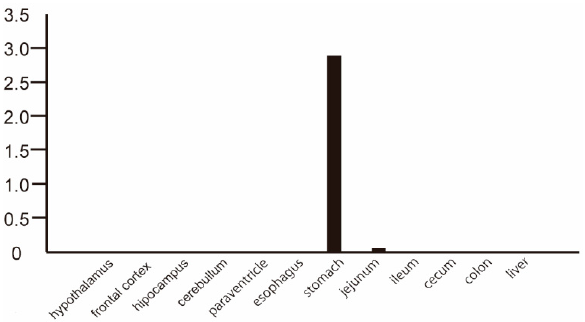
Figure 2. Accumulation of ghrelin transcripts in various tissues of human MLNR Tg mice ( n = 3). The values shown are the numbers for real-time RT-PCR products of ghrelin mRNAs normalized to those of GAPDH .